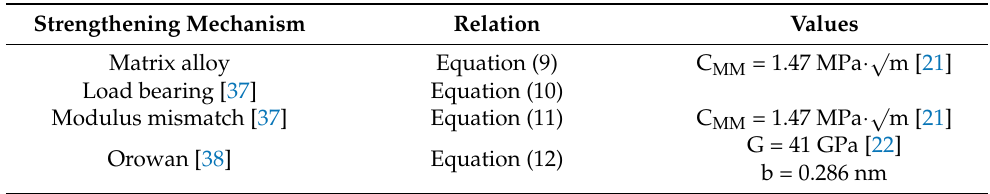
Table 5. Equations used for the contribution of the different strengthening mechanisms. Strengthening